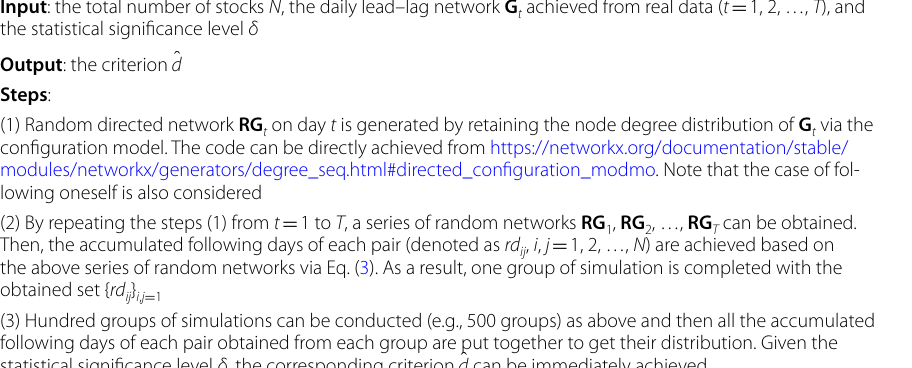
Table 1 The process of achieving the criterion ˆ